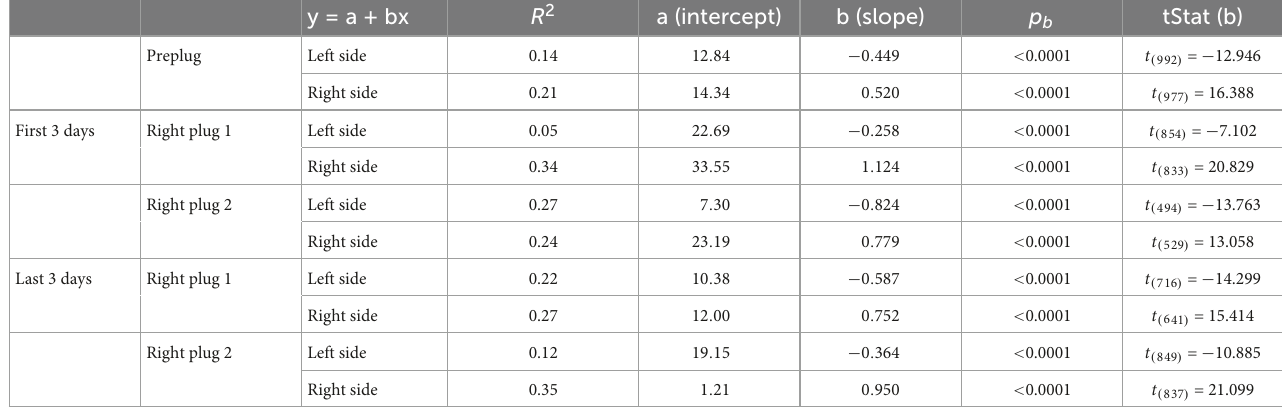
TABLE 3 Parameters of the fitted regression lines for head bearing errors in Figure 5